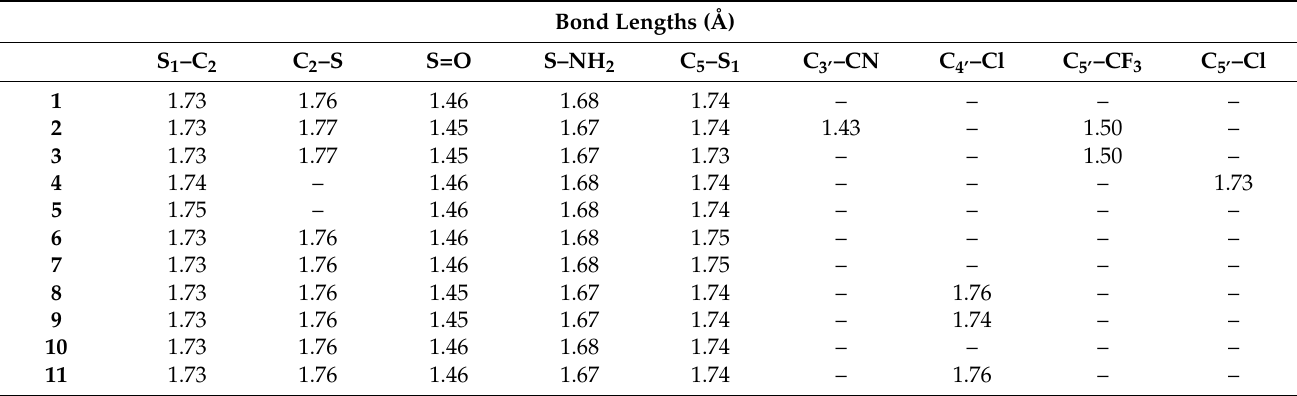
Table 1. Bond length Å of selected bonds of 1 to 11 .